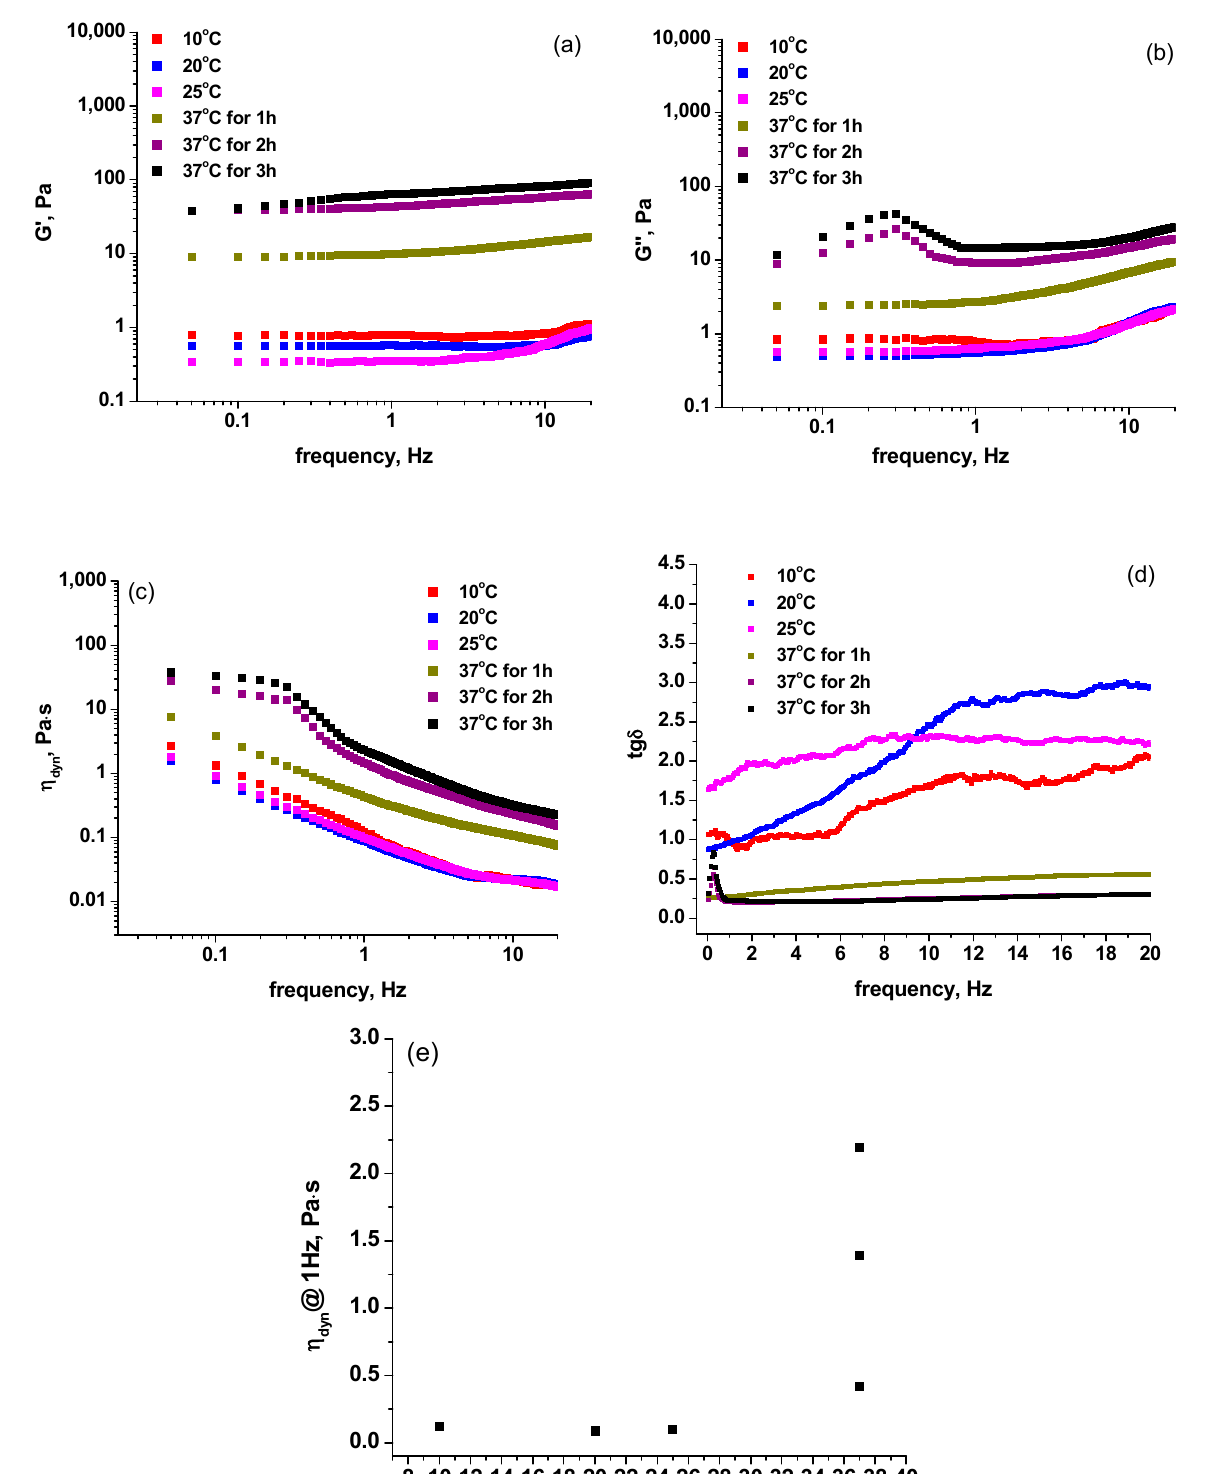
Figure 2. The variation of ( a ) storage modulus (G’), ( b ) loss modulus (G”), ( c ) dynamic viscosity ( η dyn = G”/ ω ) and ( d ) loss tangent (tg δ = G”/G’) with frequency, and the variation of η dyn with temperature ( e ) for sample 1 .